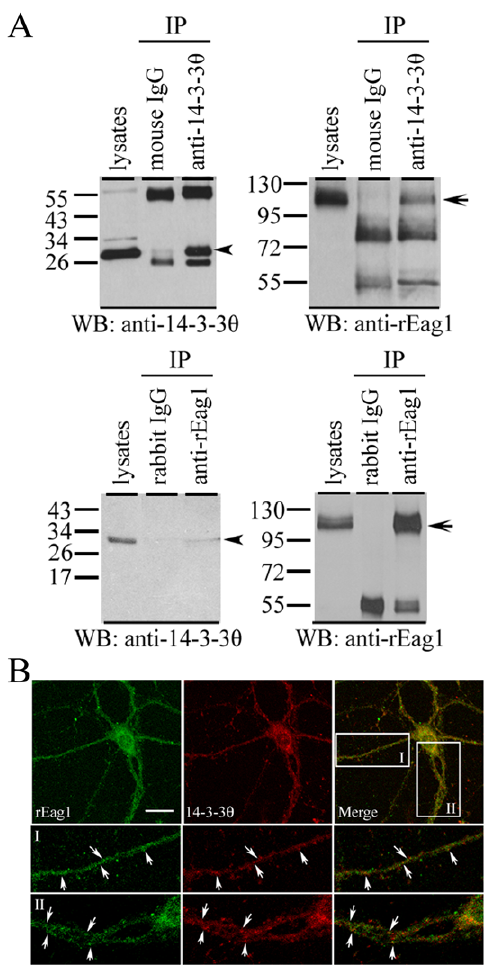
Figure 5. Endogenous expression of 14-3-3 h and rEag1 in neurons. ( A ) Co-immunoprecipitation of 14-3-3 h and rEag1. Detergent solubilized proteins from the lysates of rat forebrain were immunopre- cipitated ( IP ) with the anti-14-3-3 h ( upper panel ) or the anti-rEag1 antibody ( lower panel ), followed by immunoblotting ( WB ) analyses with the anti-14-3-3 h or the anti-rEag1 antibody. The non-immune mouse or rabbit IgG was used in parallel as negative control. Input volumes correspond to 5% of the total cell lysates used for immunoprecipitation. The arrowhead and arrow refers to the protein bands of 14-3-3 h and rEag1, respectively. ( B ) Immunofluorescence staining of rEag1 ( left panels ) and 14-3-3 h ( middle panels ) in cultured hippocampal neurons. The area highlighted in the white boxes is viewed under a higher magnification ( I, II ). Arrows label the sites of co-localization of 14-3-3 h and rEag1 ( right panels ), which displayed significant punctuate patterns over a wide region along the neurites. Scale bar, 25 m m. These co- immunoprecipitation and immunofluorescence data are representative of four to seven independent experiments.